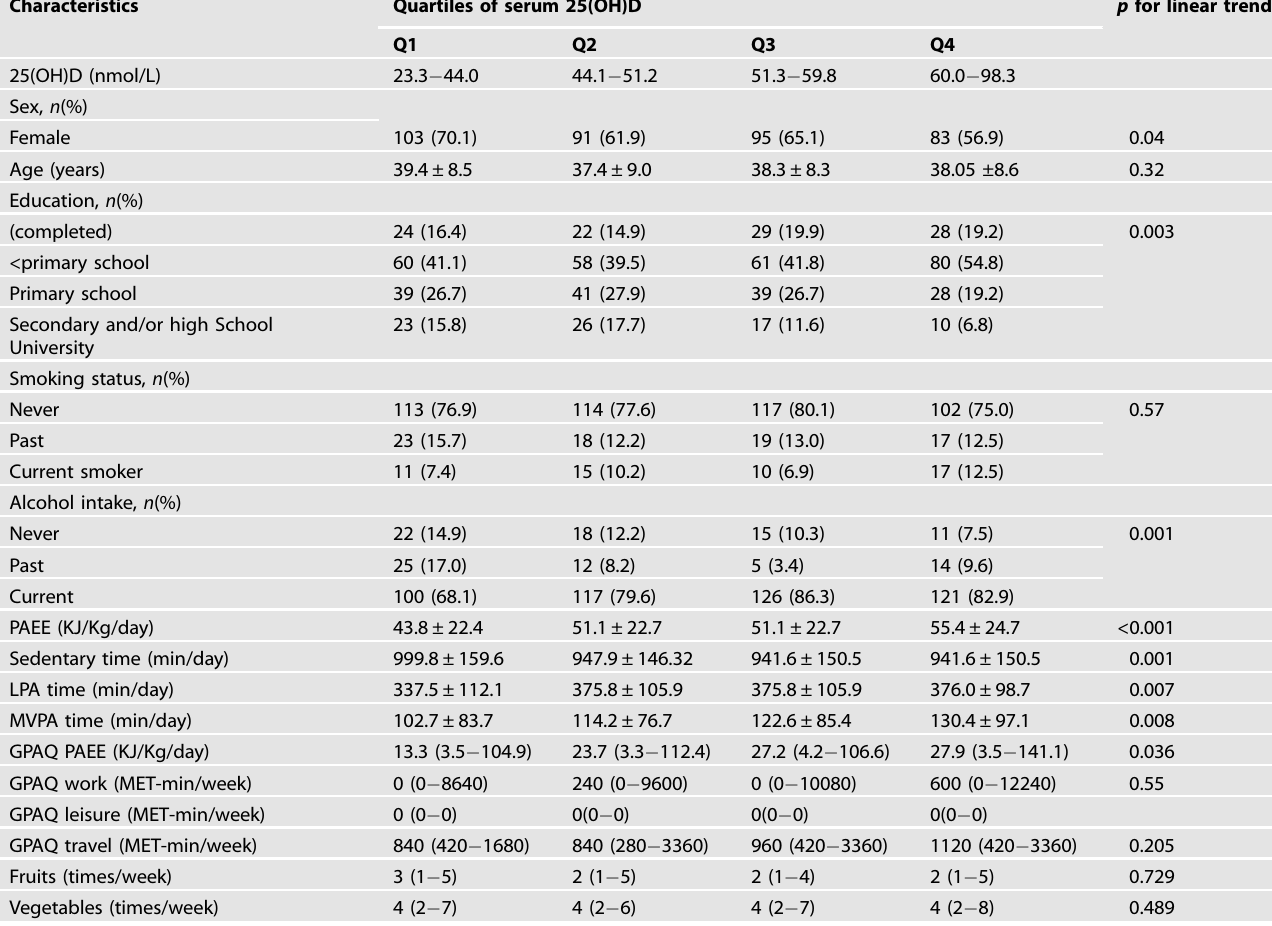
Table 1. Sociodemographic characteristics by quartiles of serum 25(OH)D concentrations (Cameroon study: n =